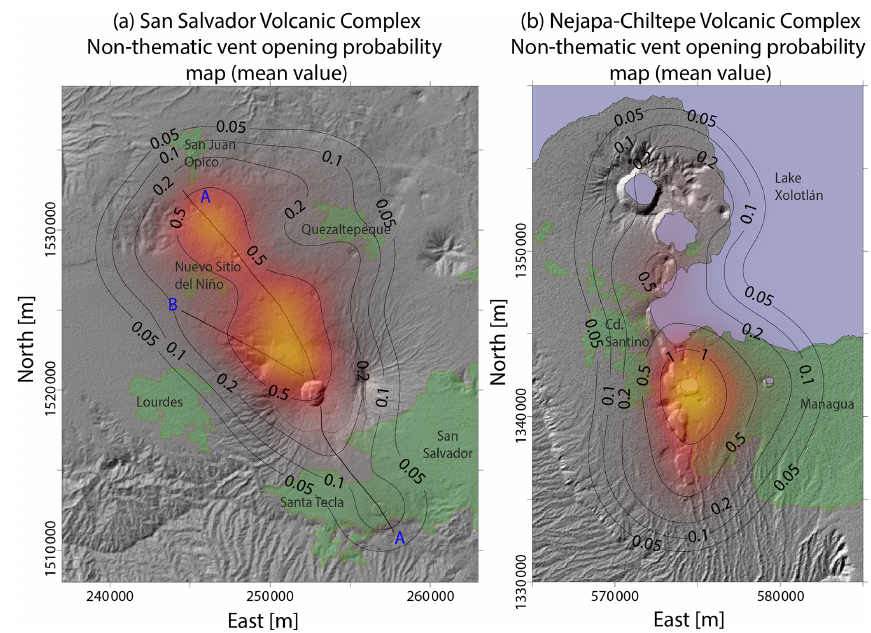
Figure 5. Density distribution of the probability of vent opening (mean value) at the San Salvador volcanic complex (a) and Nejapa-Chiltepe volcanic complex (b) . Results, which are not thematic, are expressed in percentage per km 2